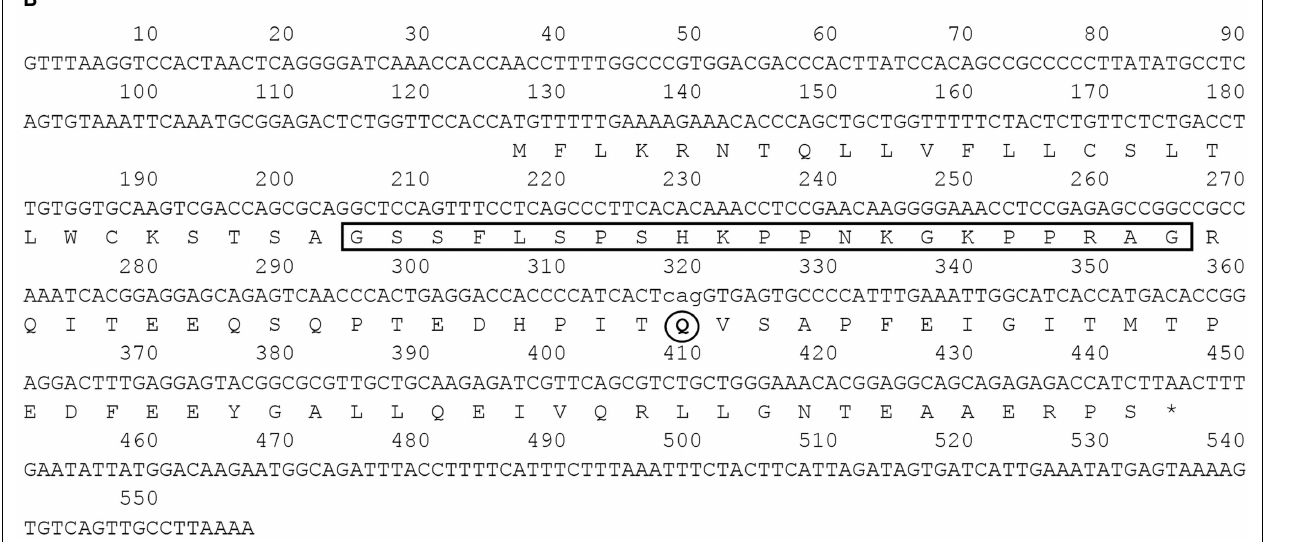
a 948-bp cDNA (acc. no. AB823534) and a 945-bp variant missing the codon for Q65 (acc. no. AB824842) and (B) a 557-bp cDNA missing the nucleotides italicized in (A) (acc. no. AB824843) and a 554-bp cDNA missing the italicized nucleotides and the codon for Q65 (acc. no.